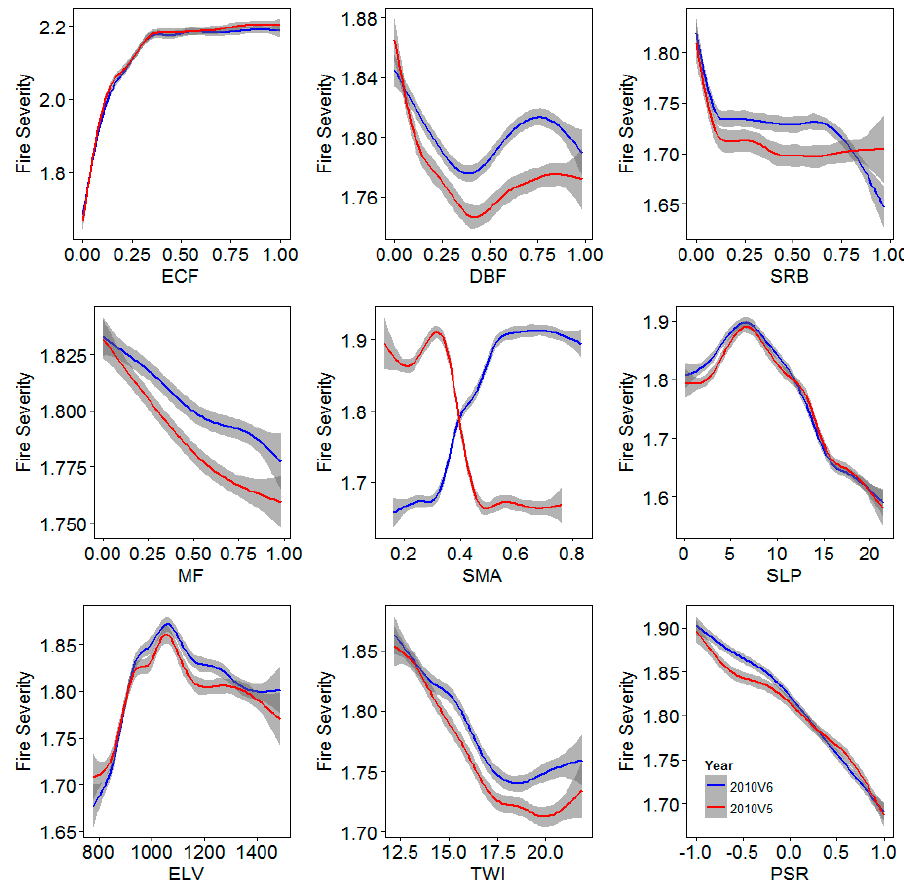
Figure A5. Partial dependence plots of nine variables on regulating fire severity in fire year 2010 using different versions of MODIS derived surface moisture availability (SMA) (Version 5 in cyan and Version 6 in red). This grouping of variables was selected as the top 9 variables following the rank as shown in y -axis of Figure 5. The curves demonstrate the smoothed means (solid line) and 95% confidence intervals (gray zone) of an ensemble of 50 models. Variable abbreviations were described in Table 2.